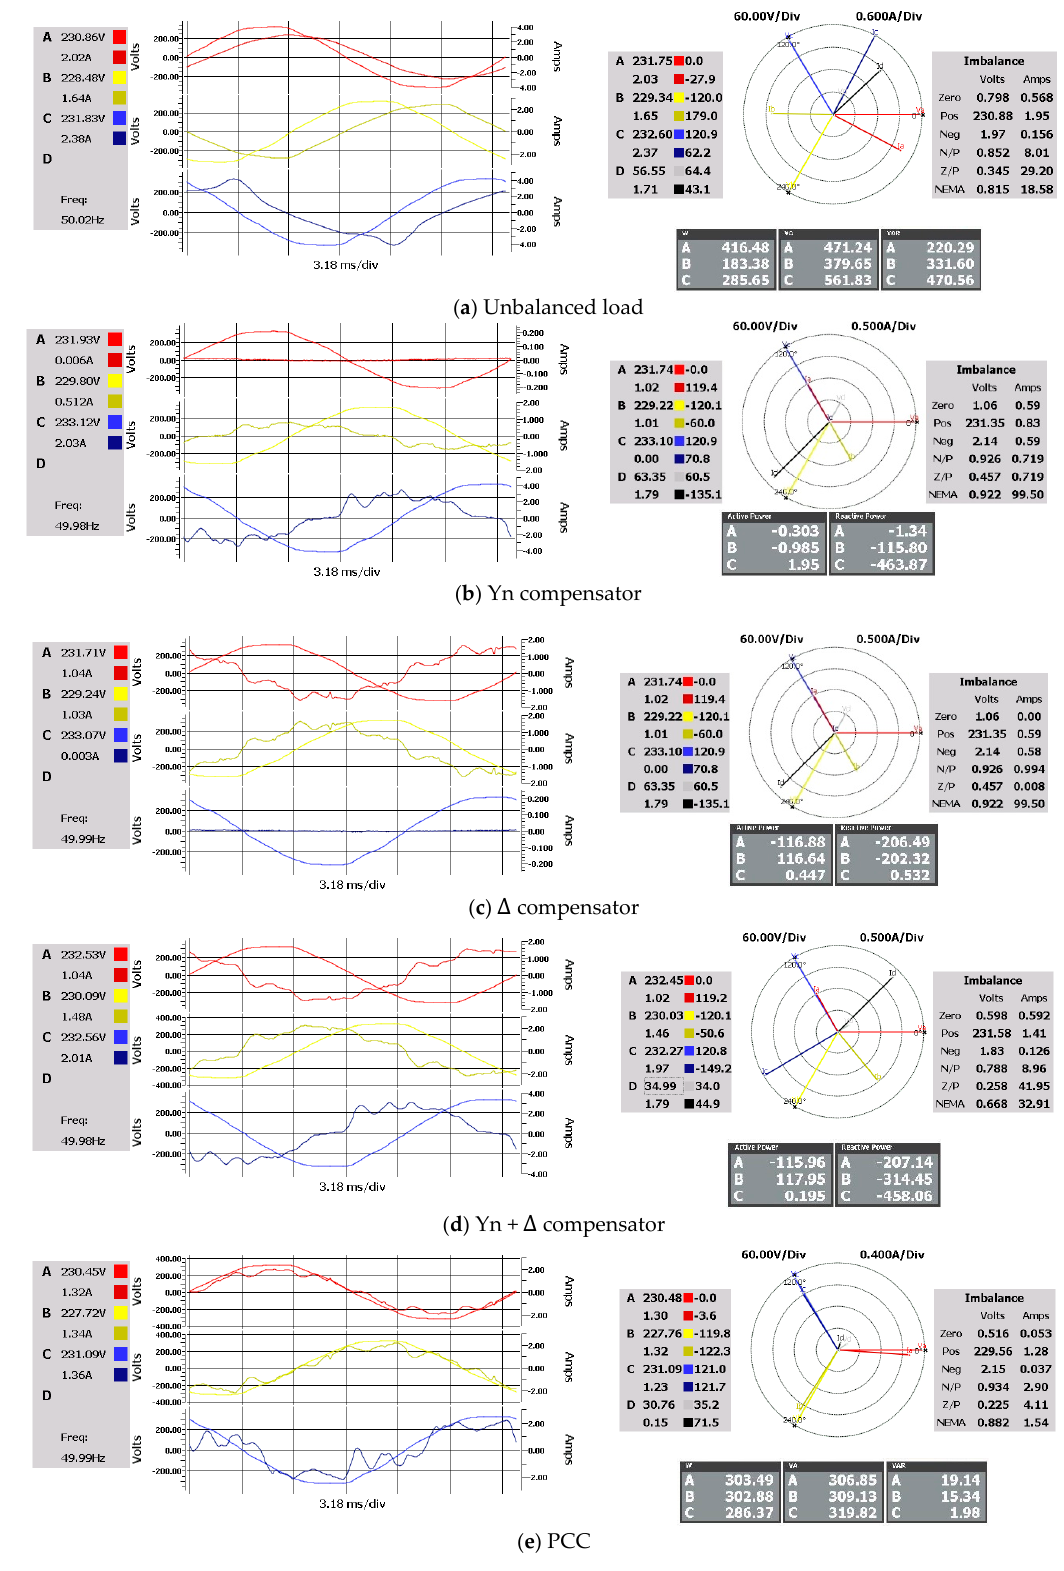
Figure 4. The results of the experimental determinations: the rms of the phase to neutral voltages, of the currents and the powers on the phases, in the five sections considered of the three-phase circuit.